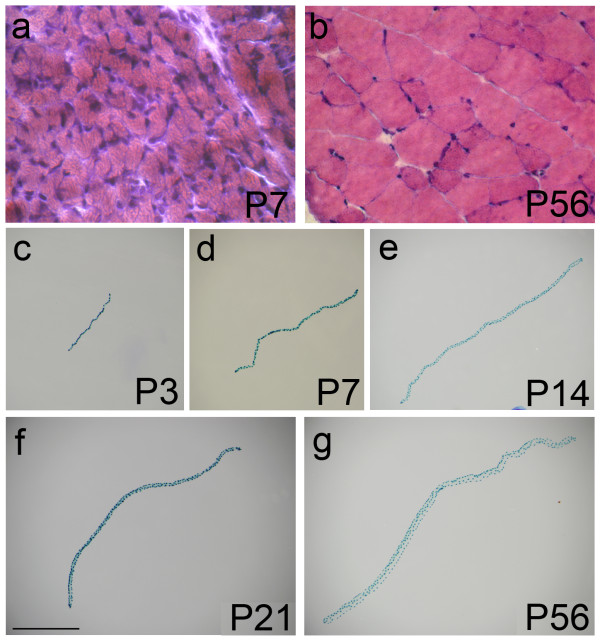
EDL myofibres from growing and adult mice. Entire EDL muscles from P3, P7 (a), P14, P21 and P56 (b) Myf5nlacZ/+ mice were cryosectioned and mid-belly sections stained with haematoxylin and eosin to determine total myofibre content and myofibre cross-sectional area. EDL myofibres were isolated from 3F-nlacZ-E mice at P3 (c), P7 (d), P14 (e), P21 (f) and P56 (g), fixed and incubated in X-gal solution to reveal the β-galactosidase activity of myonuclei by the presence of the blue reaction product. Images of representative myofibres were all taken at the same magnification and show that there is a 4.5-fold increase in length between P3 and adulthood (P56). Myonuclei appear to be uniformly distributed along the length of a myofibre at each age examined (c-g). Scale bar equals 100 μm for (a and b) and 1000 μm for (c-g).